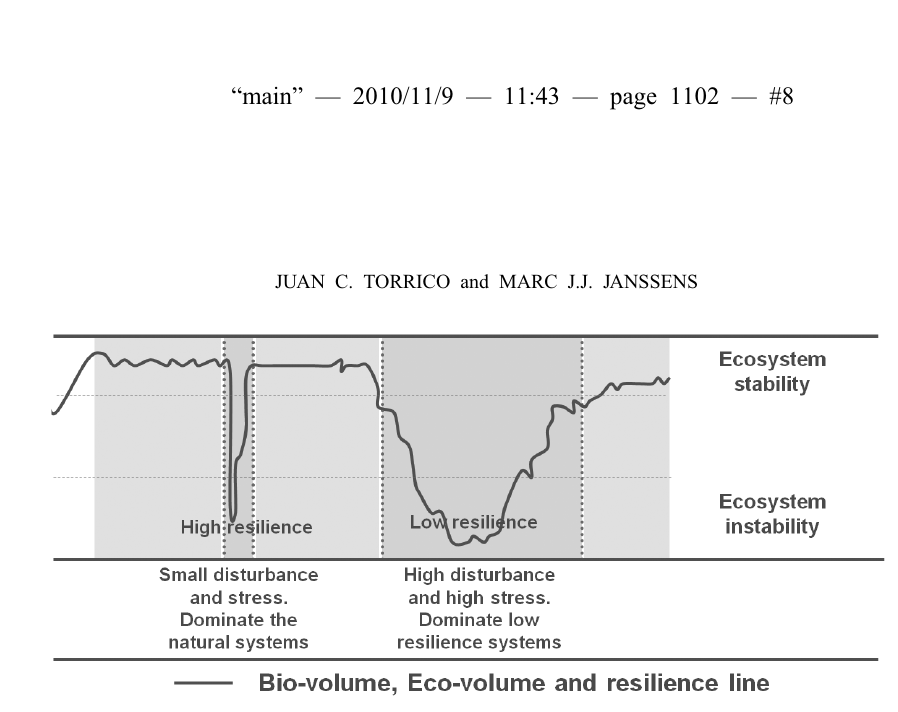
Fig. 3 – Bio-volume, eco-volume and resilience line; ecosystem stability in small perturbed and low stressed natural systems, and in high disturbed and high stressed low resilience systems. Ecosystem stability as a function of recovery